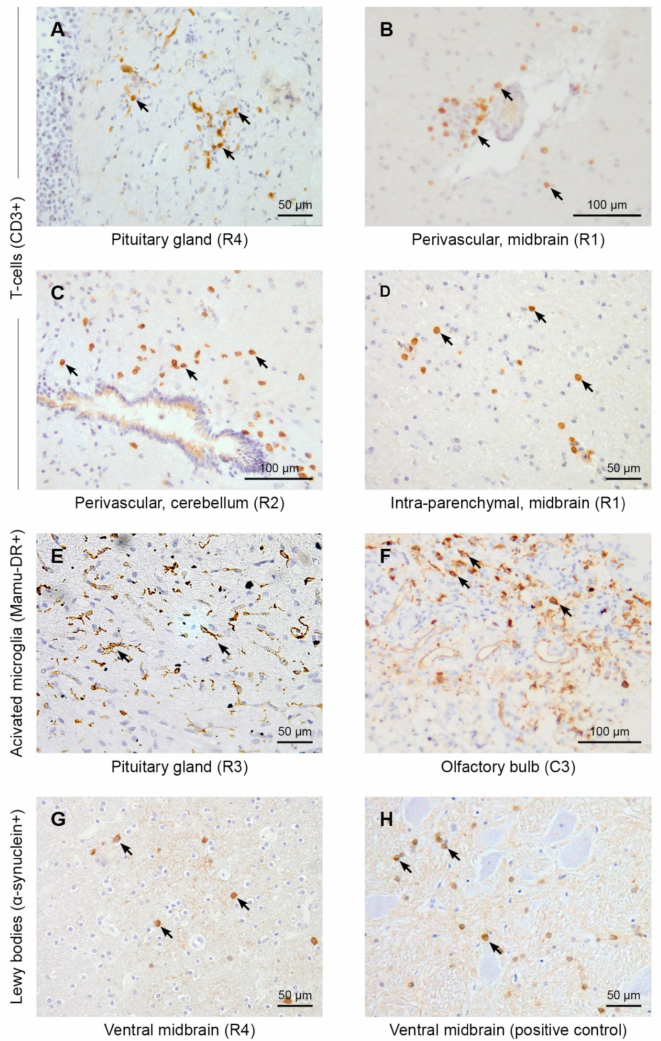
Figure 4. SARS-CoV-2 causes brain inflammation and Lewy body formation in brains of macaques. The immunohistochemistry of macaque brain tissues (20 × ). Arrows indicate the presence of some clear positive cells for the immunohistochemical staining. First and second row: CD3+ T-cells. In infected animals, T-cells were found in the pituitary gland ( A ), perivascular ( B , C ), and in the brain parenchyma ( D ). Third row: Mamu-DR+-activated microglia cells. Activated microglia cells are shown in the pituitary gland of R3 ( E ). Amoeboid microglia cells are shown in the olfactory bulb of C3 ( F ). Bottom panel: α -Synuclein positive staining was found in the ventral midbrain in all SARS- CoV-2-infected rhesus macaques. α -Synuclein accumulations were found in the ventral midbrain region, next to the caudate nucleus ( G ). A positive control of the α -synuclein staining of a brain slice from a 22-year-old cynomolgus monkey, showing signs of parkinsonism from the brain bank of the BPRC, is shown ( H